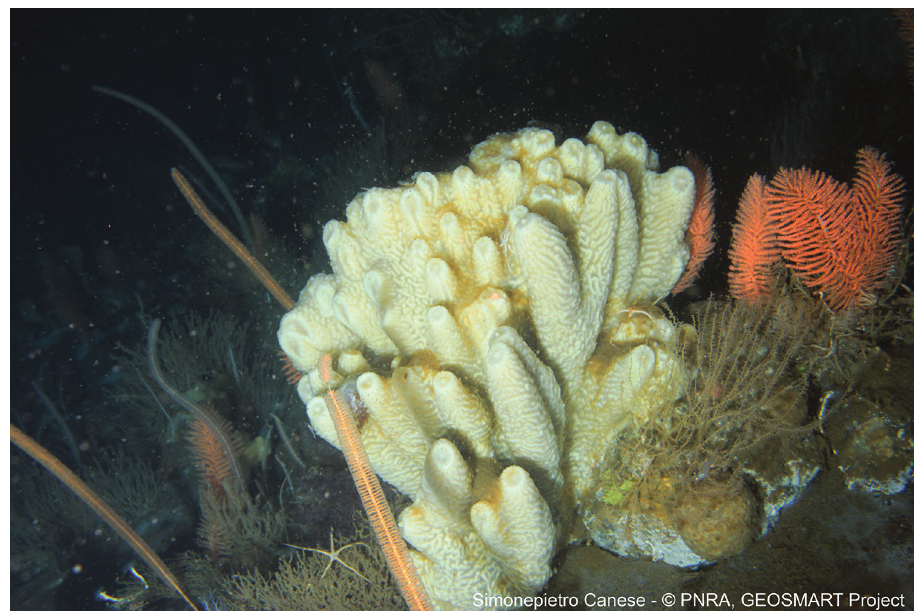
Figure 8. ROV video frame of the species Tedania (Tedaniopsis) oxeata Topsent, 1916 (MNA 8244) found at 250 meters of depth before the use of the ROV arm to obtain a fragment. Table 1. Sponge holotypes stored at the